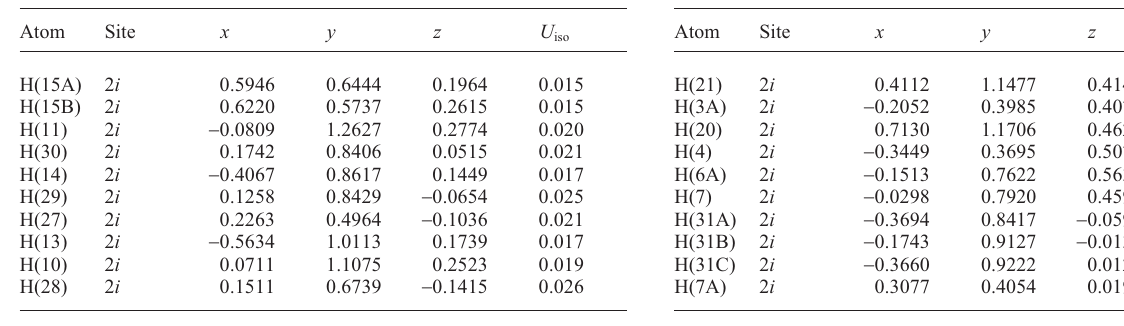
Table 3. Atomic coordinates and displacement parameters (in Å 2 )